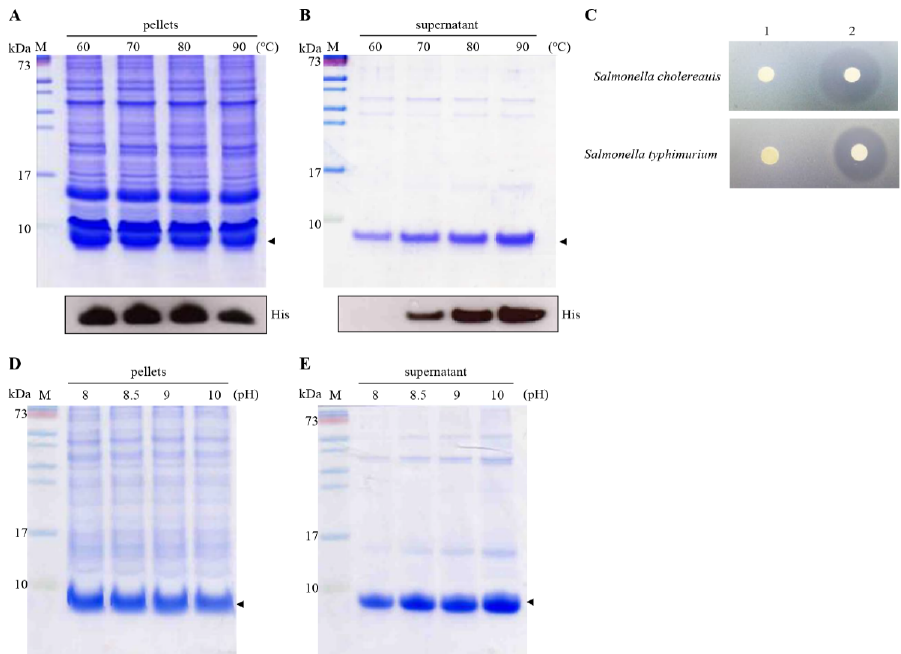
Figure 6. Treatments of inclusion bodies with different temperatures and pHs. ( A , B ). Inclusion bod